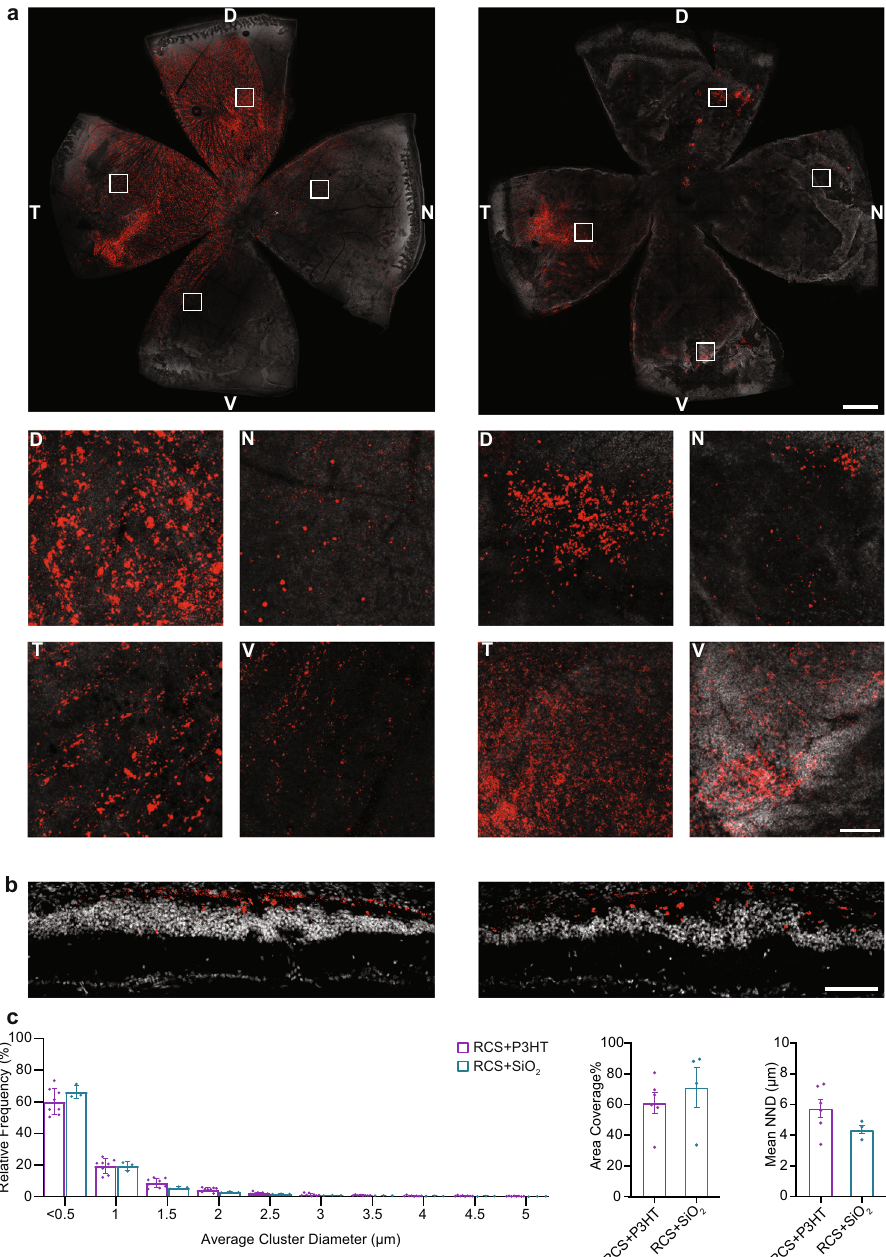
Fig. 2 Distribution of fl uorescent P3HT- and SiO 2 -NPs after subretinal injection in old dystrophic RCS rats. a Whole-mount retinas from 13/15-month- old RCS rats were analyzed by confocal z-stack scans in which the localization of P3HT-NPs ( left ) and SiO 2 -NPs ( right ) (intrinsic fl uorescence in red) is clearly visible with respect to retinal cells (nuclear staining with bisbenzimide in white). Each panel represents the z-max with local magni fi cations of dorsal (D), nasal (N), ventral (V) and temporal (T) regions of the retina, highlighting the degree of dispersion of the P3HT- and fl uorescent SiO 2 -NPs. Scale bar, 1 mm, high magni fi cation areas 0.5 × 0.5 mm. Inset scale bar, 100 µ m. b Transversal retinal sections from dystrophic RCS rats injected with either fl uorescent P3HT-NPs or fl uorescent SiO fl uorescence (red) was merged with bisbenzimide nuclear staining (white). The images 2 -NPs at 30 DPI. NP emphasize the stable subretinal location of injected NPs, with no tendency to permeate the internal retinal layers. Scale bar,100 µ m. c Histogram showing the frequency distribution of average cluster diameters ( left ), the extent of retina coverage ( middle ) and the nearest neighbor distance (NND; right ) for P3HT-NPs and fl uorescent SiO 2 -NPs. The estimated diameter of each NP cluster was calculated as the average of the three dimensions of each isolated fl uorescence volume ’ s bounding box. About 40 – 60% of the volumes have diameters below 500 nm in all cases, with an average of almost monodisperse NPs (>50%) regardless of age. Data are shown as means± sem with individual experimental points. Sample size: n = 3 (RCS + SiO 2 ) and 8 (RCS + P3HT) for cluster volumes, n = 4 (RCS + SiO 2 ) and 6 (RCS + P3HT). Kolmogorov-Smirnov and Mann – Whitney U tests. For exact p -values and source data, see Source data fi